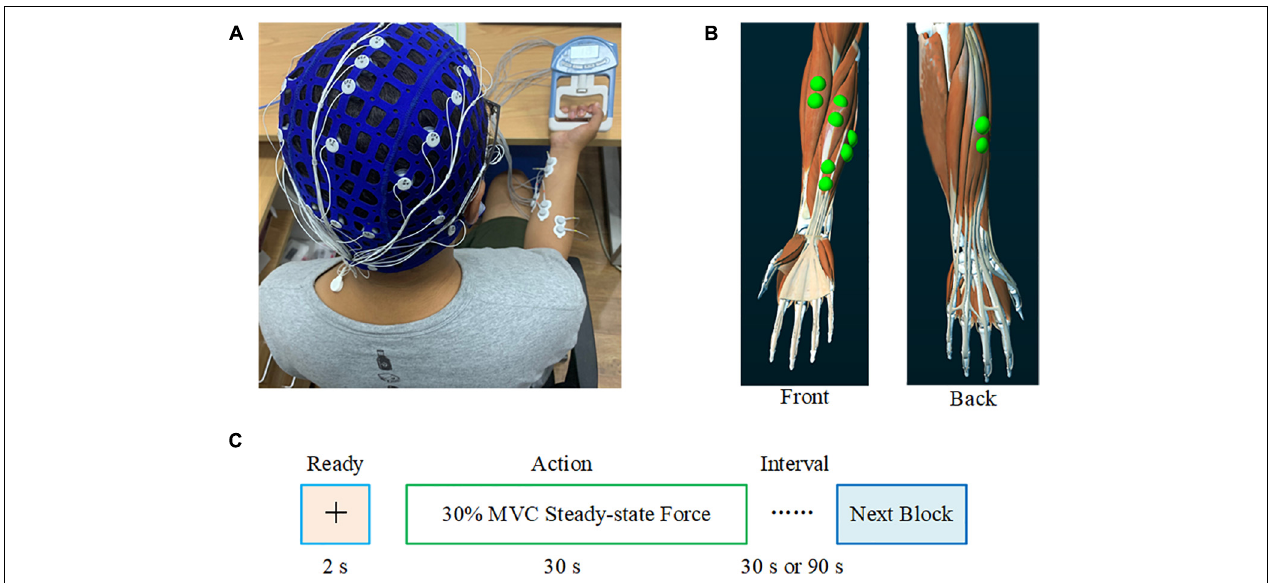
FIGURE 1 | Experimental setting. (A) Synchronous recording of the subjects’ EEG and sEMG. (B) The electrode position on the FDS, FCU, FCR, BR, and ED. (C) The experimental paradigm. During the pre-fatigue task, the interval between each block was 90 s; during the post-fatigue task, this interval was 30